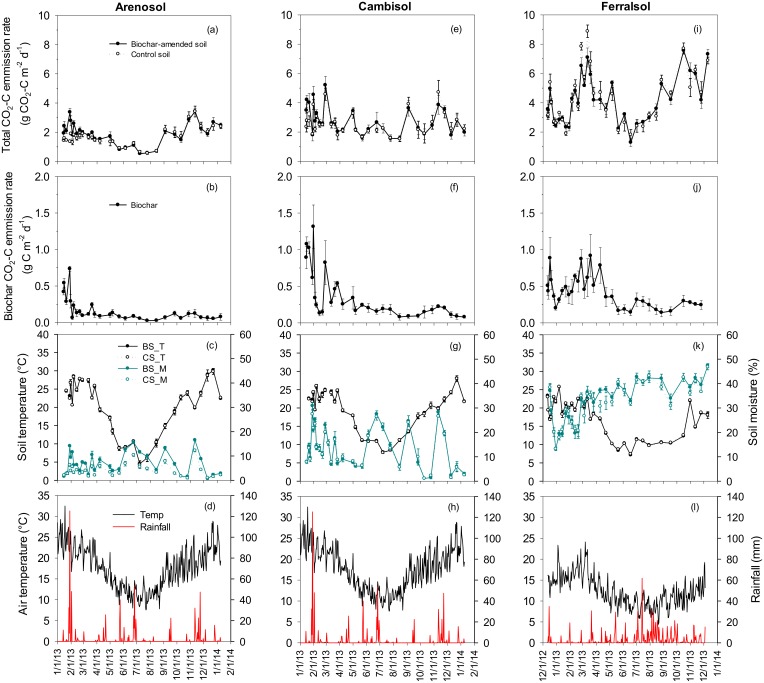
Total daily CO2-C emission and biochar-C mineralisation rates in the biochar-amended and control Arenosol, Cambisol and Ferralsol.The bottom two panels includes soil temperature at 5-cm depth, volumetric soil water content at 0−10-cm depth, mean air temperature (an average of maximum and minimum) and rainfall over the 12 months at the Cobbitty field site in New South Wales and at the Elliot site in Tasmania. The weather data were downloaded from the nearest weather station at the Camden airport (http://www.bom.gov.au/) and University of Tasmania (http://console.weatherdata.com.au/index.html). The symbols of biochar-amended and non-amended (control) micro-plots are filled and empty circles, respectively. Error bars are ± standard errors (n = 4).